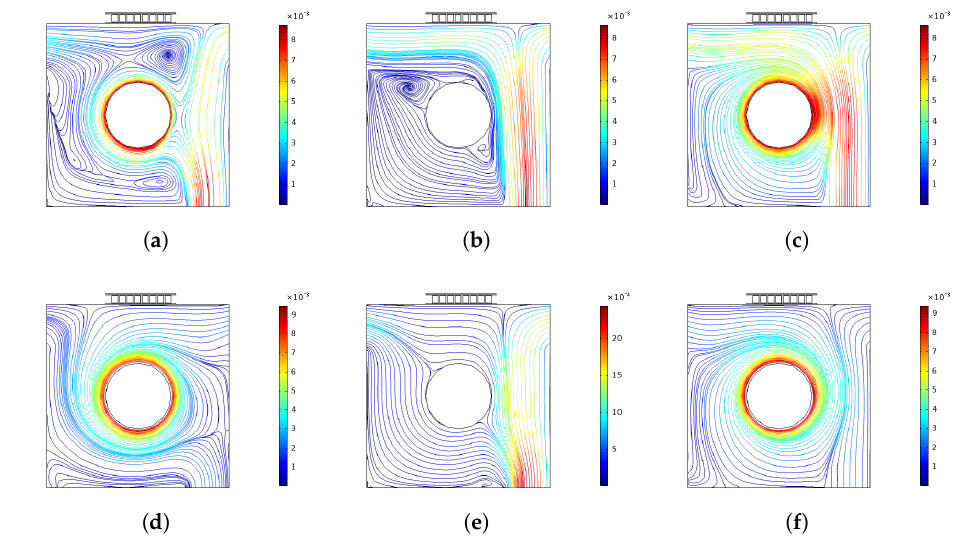
Figure 5. FP distributions in the VC with varying Rew for both nanofluids (R = 0.18 Hm, (Yp, Zp) = (0.5, 0.5)). ( a ) Rew = − 3000, NF1, ( b ) Rew = 0, NF1, ( c ) Rew = 3000, NF1, ( d ) Rew = − 3000, NF2, ( e ) Rew = 0, NF2, ( f ) Rew = 3000,